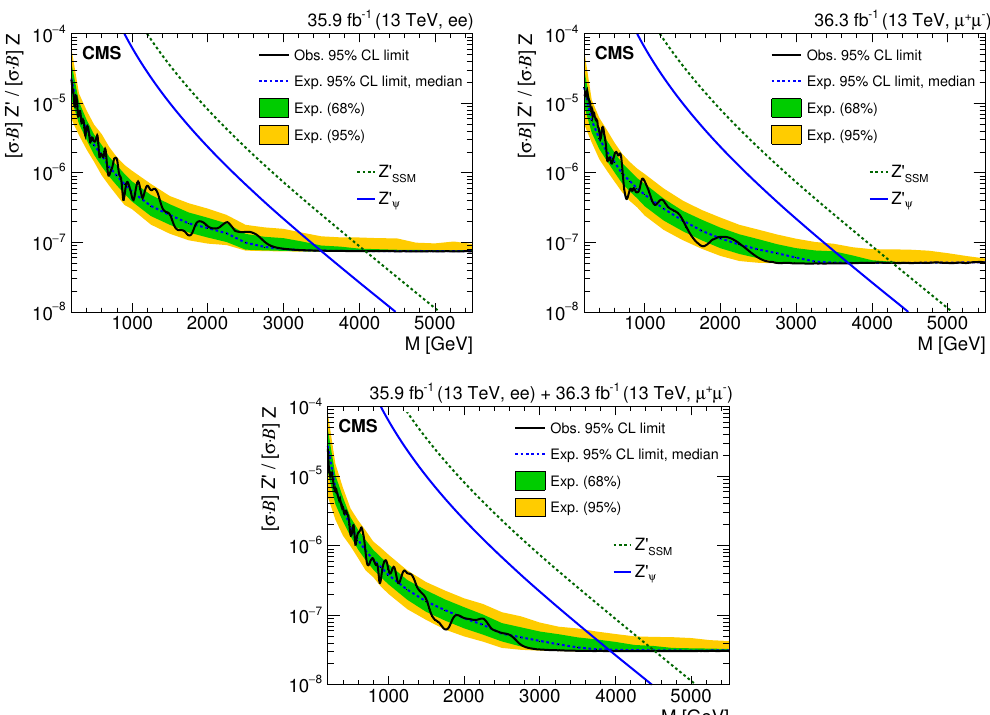
Figure 3 . The upper limits at 95% CL on the product of production cross section and branching fraction for a spin-1 resonance with a width equal to 0.6% of the resonance mass, relative to the product of production cross section and branching fraction of a Z boson, for the dielectron channel (left), dimuon channel (right), and their combination (lower). The shaded bands correspond to the 68 and 95% quantiles for the expected limits. Theoretical predictions for the spin-1 Z 0 resonances are shown for